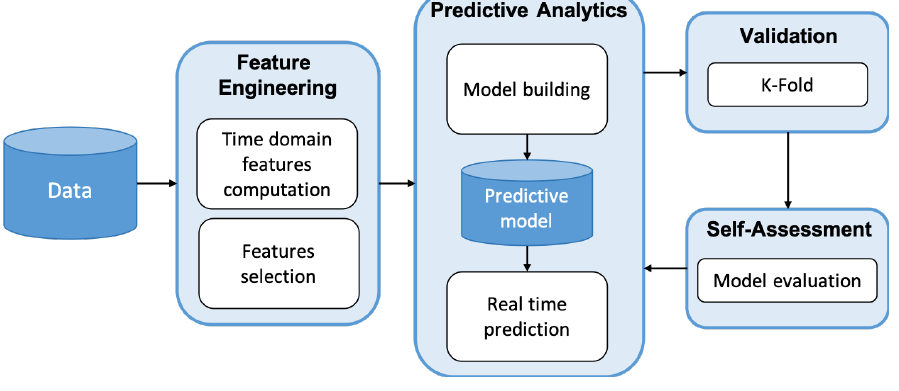
Figure 2. Analytic